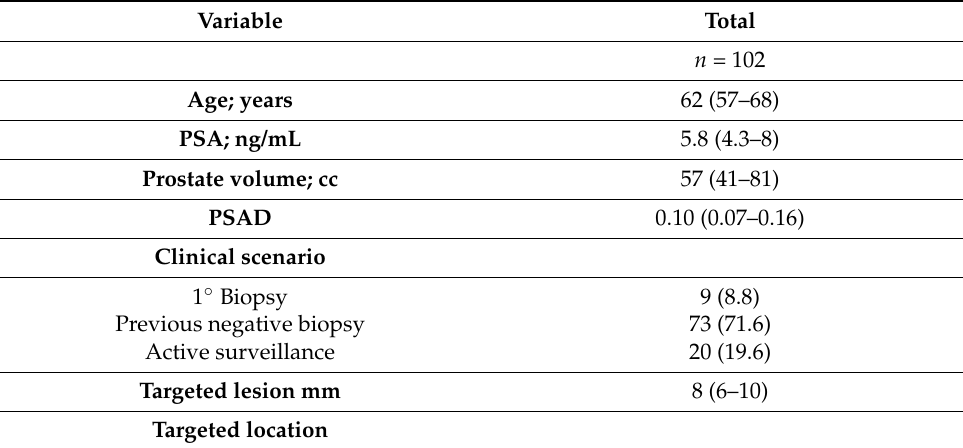
Table 2. Characteristics and description of the PI-RADSv.2 score 3 cohort.